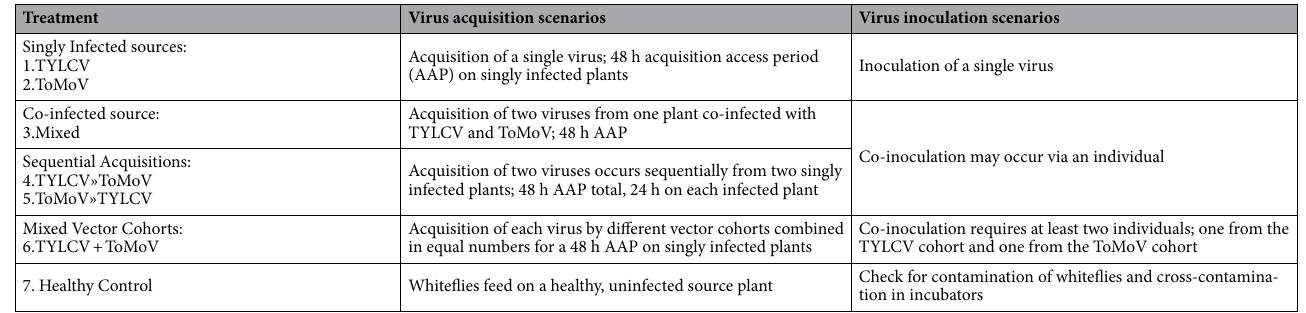
Table 1. Treatments in this experiment were designed to compare acquisition and transmission of single and co-infections TYLCV and ToMoV under different acquisition and inoculation scenario